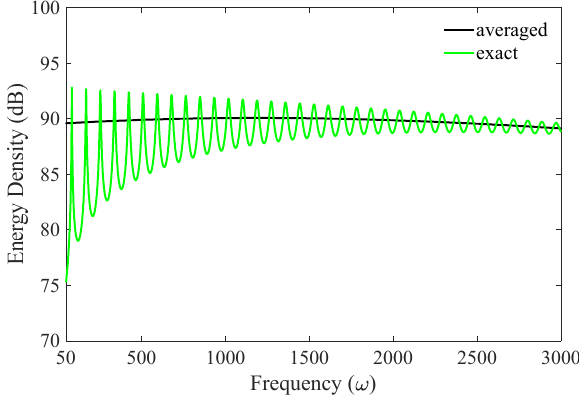
Figure 2. A membrane connected to a supported frame excited by a point force.